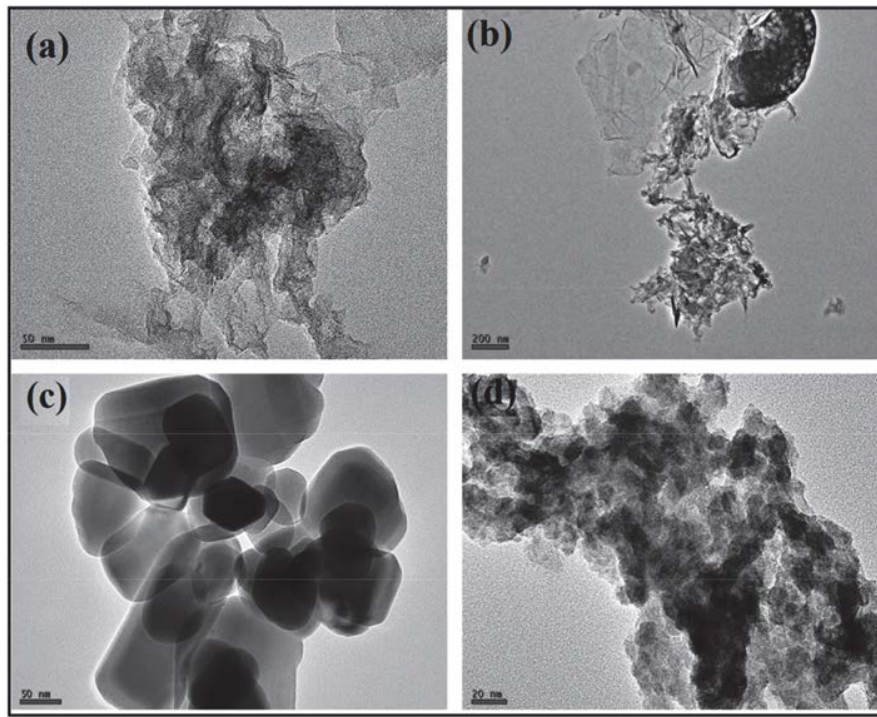
Figure 7. TEM micrographs of (a) GO (b) NG (c) ZnO (d)